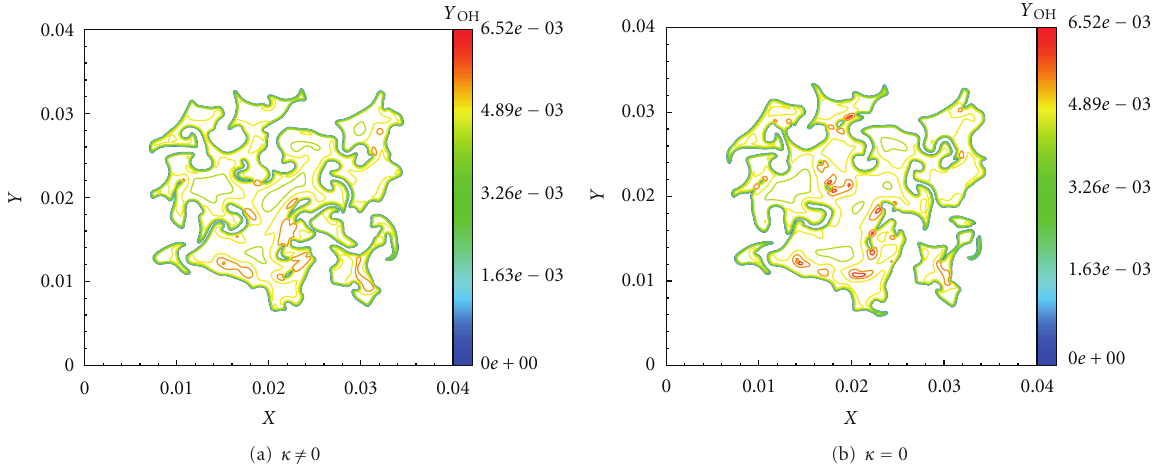
Figure 8: Instantaneous flame front defined by the iso-contours of the mass fraction of OH (along the z = 2 . 0 cm plane) for case 3 at t = 1 . 2 τ with (a) and without (b) volume viscosity e ff